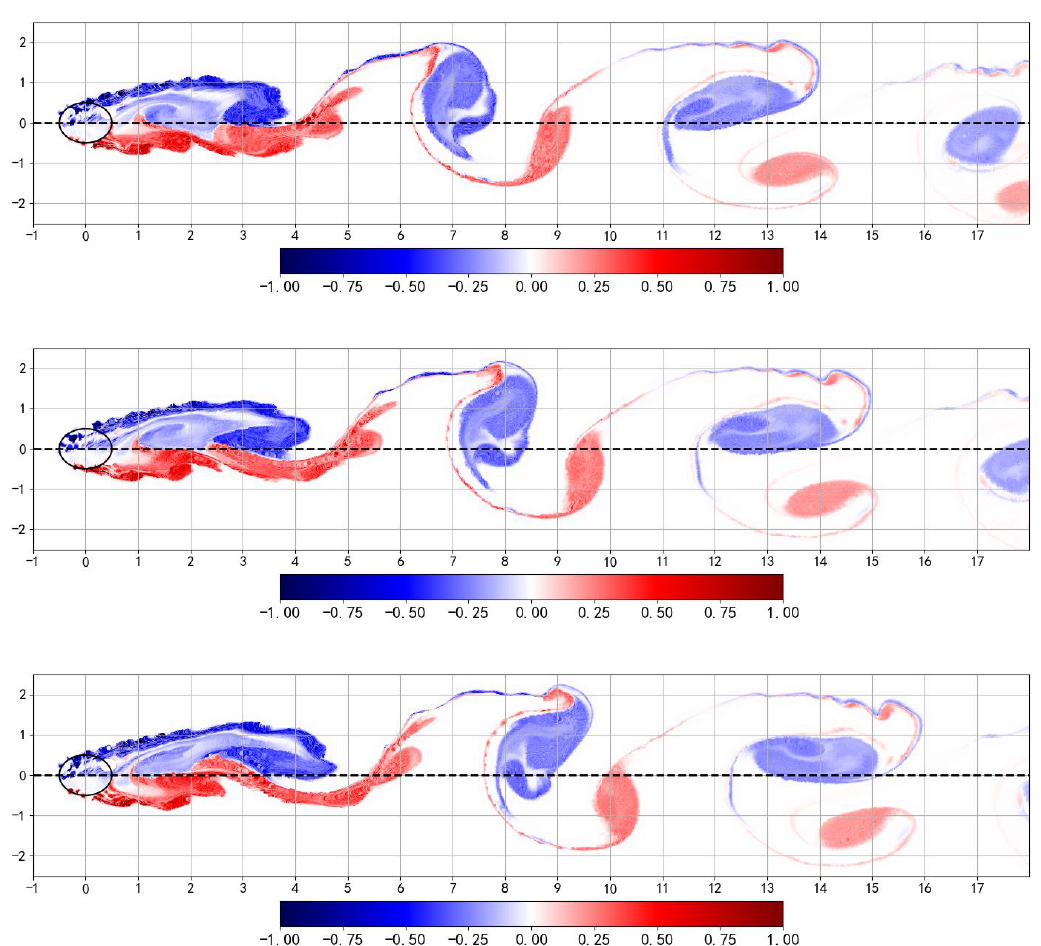
Figure 10. The eight moments of vorticity field in one period at a wide view. The interval of each moment is approximately equal to one rotation period. The X-axis is the streamwise position, which is normalized by the turbine diameter ( X/D ). The Y-axis is the lateral position, which is normalized by the turbine diameter ( Y/D ). The color bar is the nondimensional vorticity, which is normalized by the maximum vorticity in the field ( ω/ω max ).